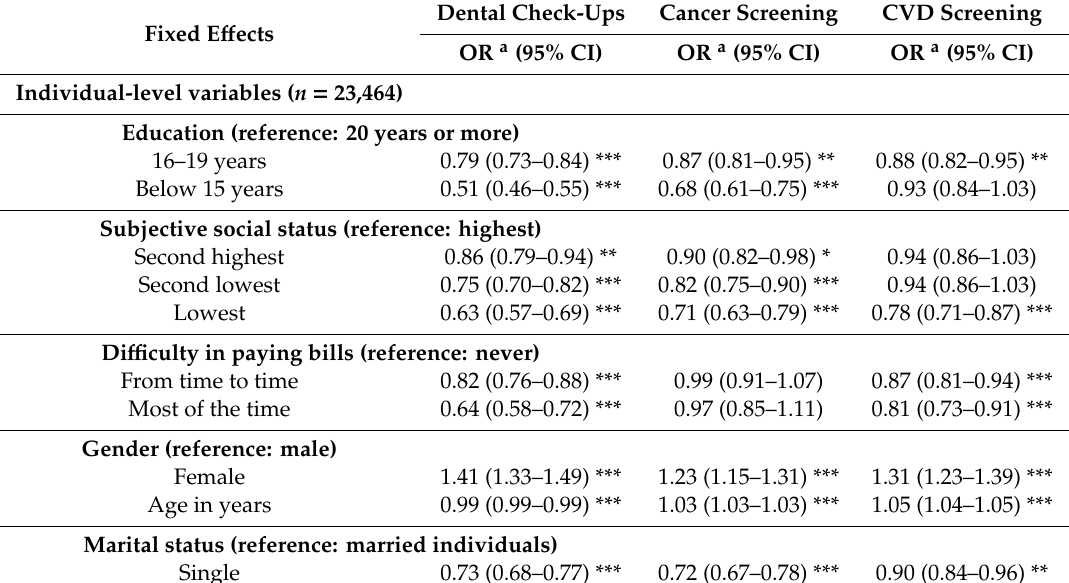
Table 3. Socioeconomic inequalities in use of dental and medical preventive services among adults aged 20 + years old in European Union